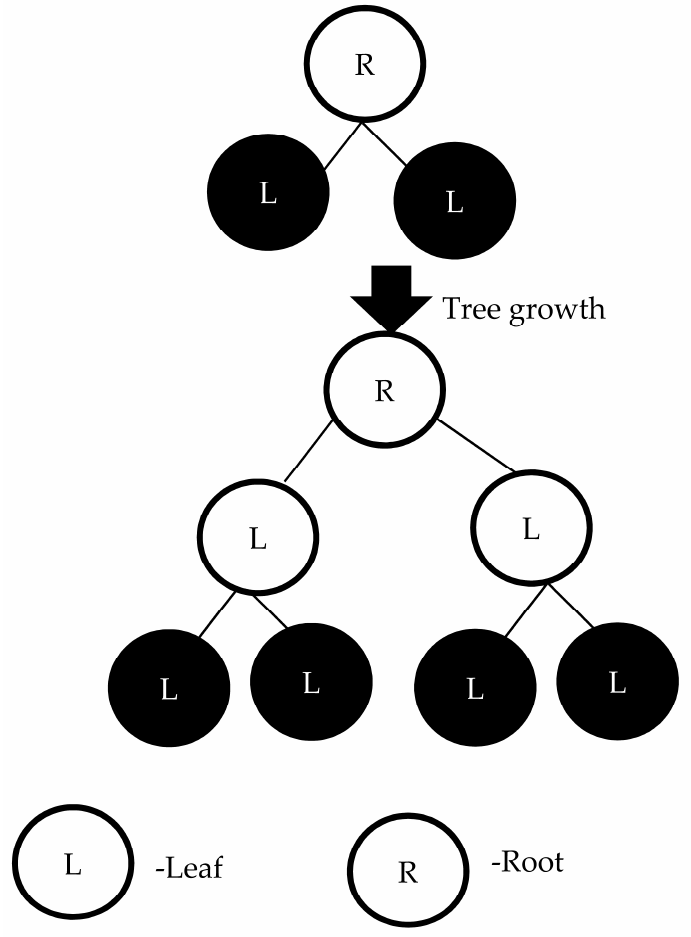
Figure 2. The tree grown level-wise.